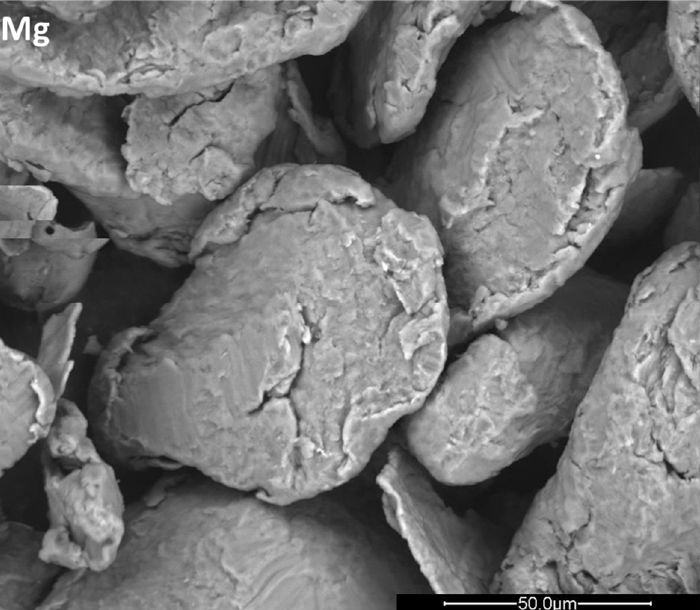
Figure 3. Scanning electron microscope (SEM) image of the magnesium particles (typical size 70–80 microns) used as a water-reactive component of the fuel grain.